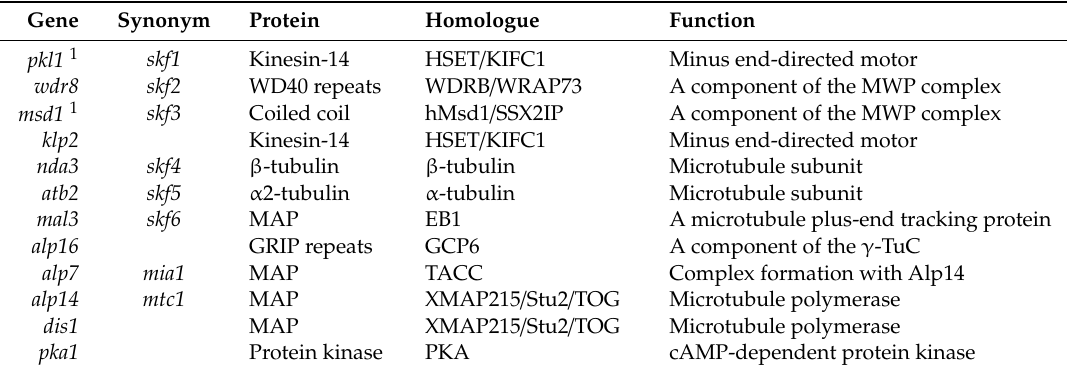
Table 1. List of spindle inward force generators in fission